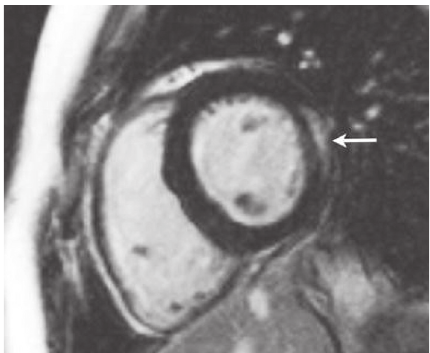
Figure 3: Short axis reconstructed IR-TrueFISP image through the mid-ventricle demonstrates subepicardial linear delayed en- hancement (arrow) in the lateral wall of a patient who had received trastuzumab [69]; reprinted with permission from Wadhwa et al.